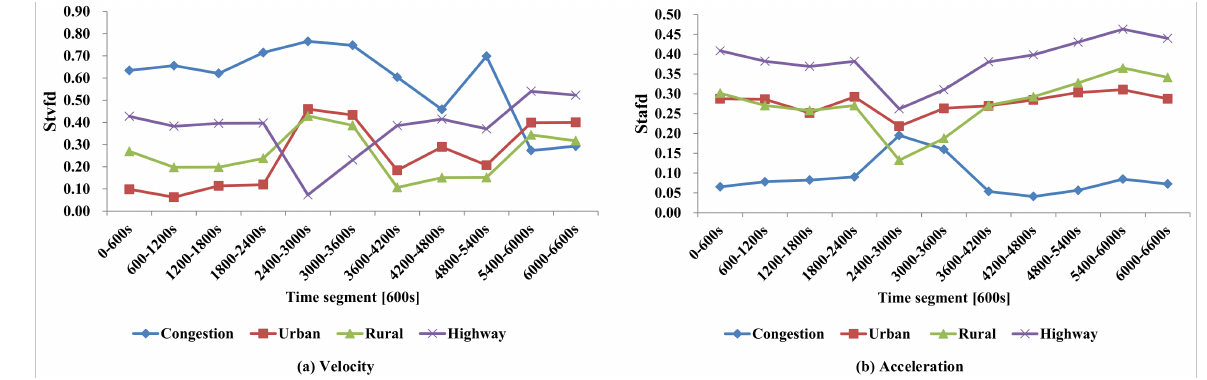
Figure 14. Classifying windows with velocity vector and acceleration vector.